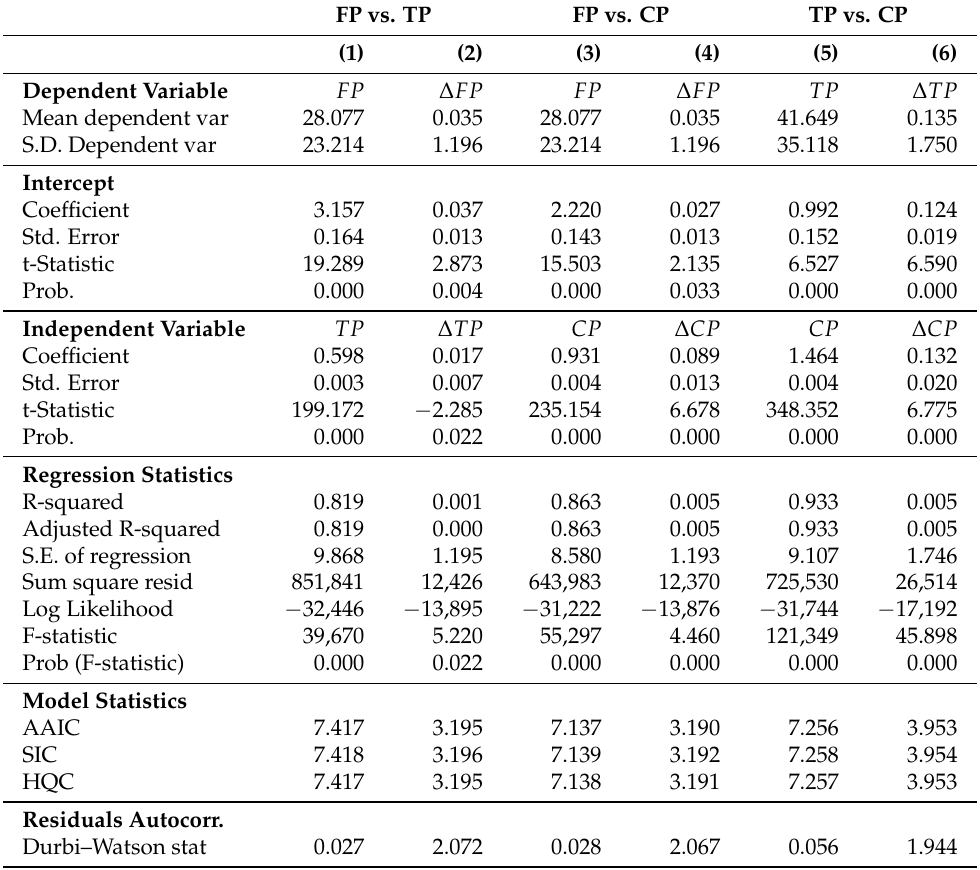
Table A2. Pre-crisis period panel regressions.